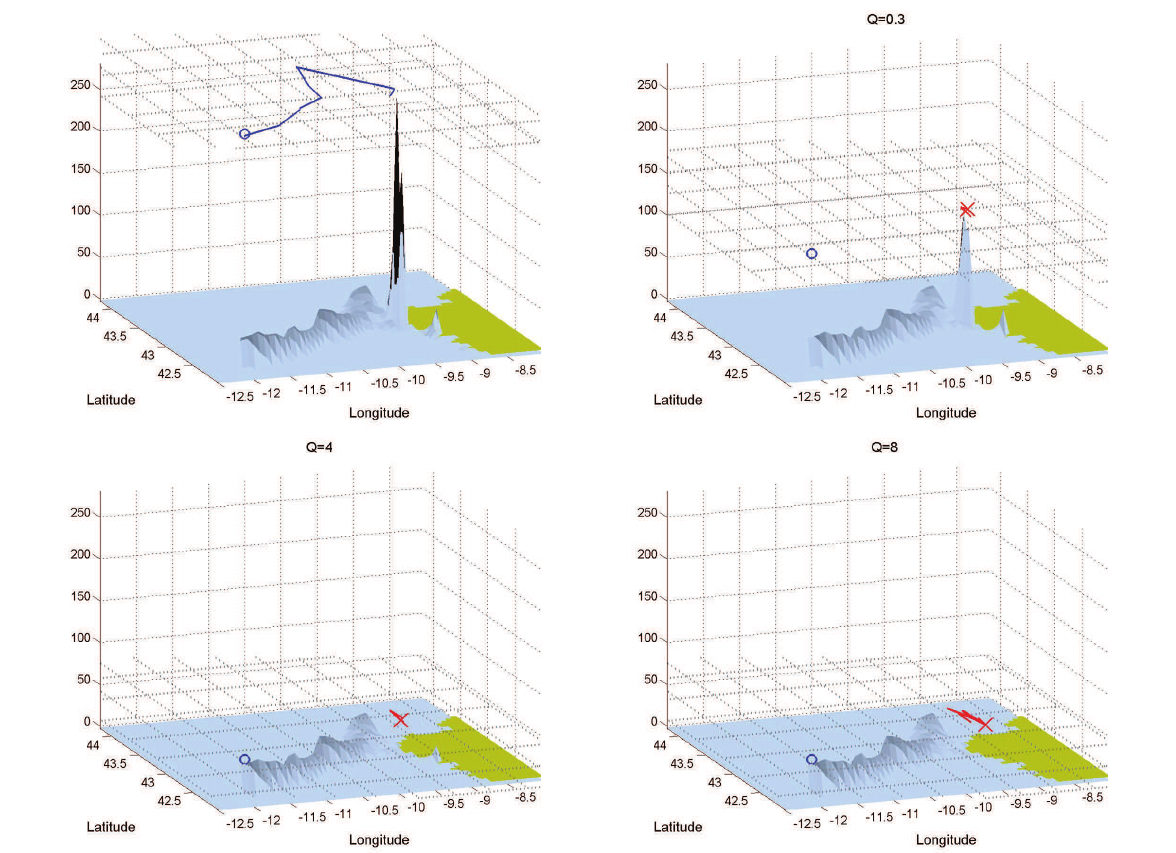
Fig. 10 3D view of the final oil concentration distribution on 19 November 2002 for the experiments: ( Top-Left ) no pumping process, ( Top-Right ) OPT-0.3- (4), ( Bottom-Left ) OPT-4- (4) and ( Bottom Right ) OPT-8- (4). A plane at the same height as the maximum value of the oil concentration is also presented. In this plane the skimmer ship trajectory (continuous red line), the Prestige ship trajectory with no pumping process(continuous blue line), final position of the skimmer ship (x) and final position of the Prestige ship (o) are